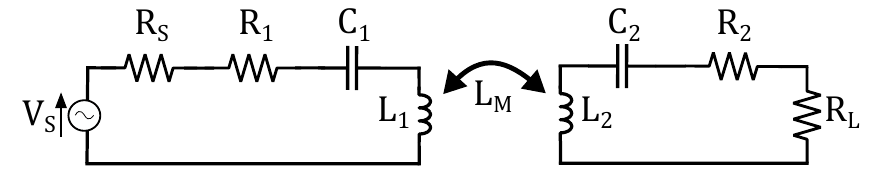
Figure 4. Equivalent circuit representation of a general inductive wireless power transfer (IPT) system.